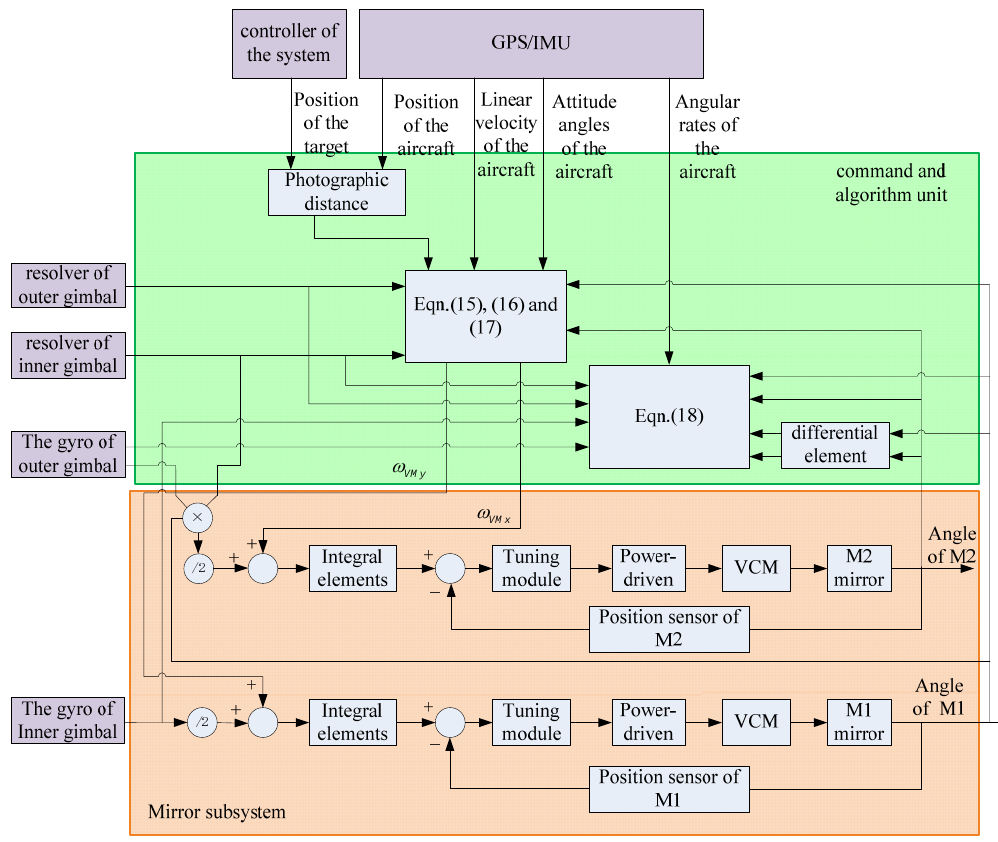
Figure 6. Block diagram of image motion compensation.